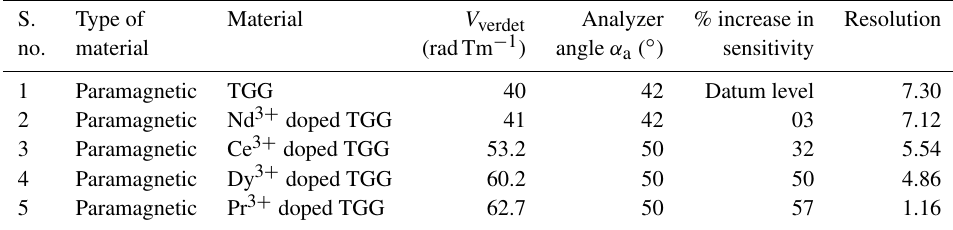
Table 5. Maximum sensitivity achieved at 632.8nm wavelength for magnetic field range 0–10mT (corresponding to Fig. 5). S. Type of Material V verdet Analyzer Resolution no. material (radTm − 1 ) angle α a ( ◦ ) 1 Diamagnetic Dynasil 1001 2 Diamagnetic BK-7 glass Diamagnetic YAG Paramagnetic TDG Paramagnetic TGG